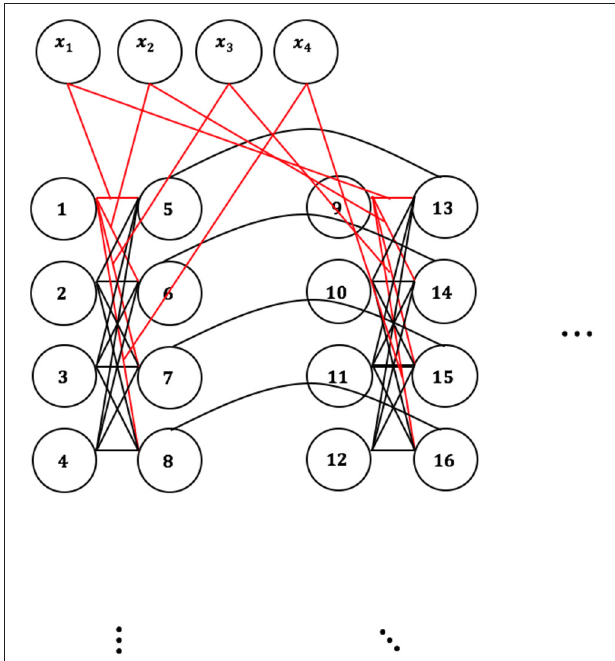
FIGURE 3 | Feeding an instance into the cluster-form.